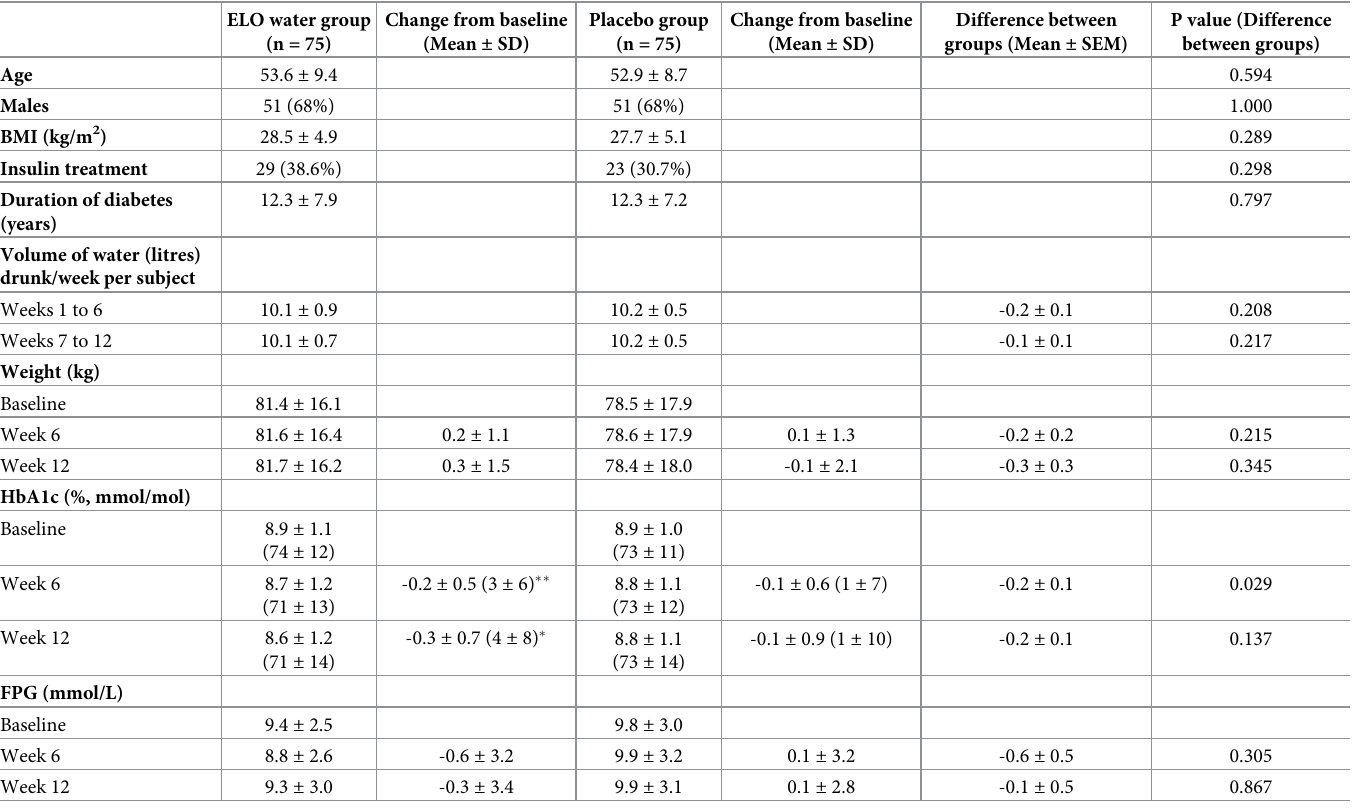
Table 1. Baseline demographics, and changes in weight and glycaemic control from baseline, with ELO versus placebo drinking water.